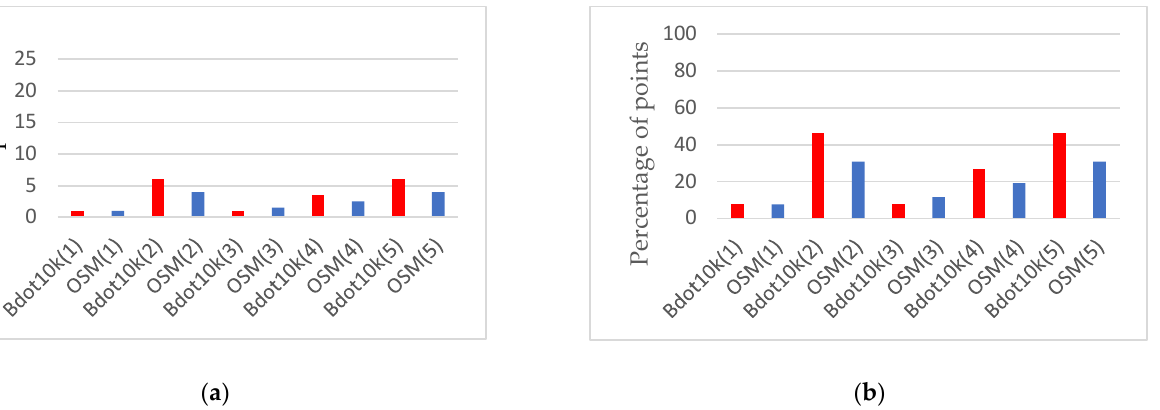
Figure 6. Usefulness of BDOT10k and OSM data — the third level of map detail: ( a ) sum of points; ( b ) percentage of points.